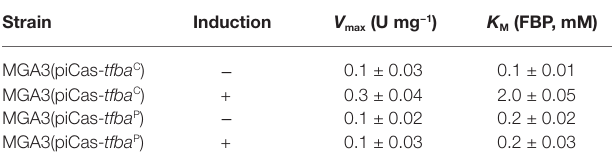
TABLE 3 | FBA (FBP cleavage) activities in crude extracts of Bacillus methanolicus MGA3(piCas- tfba C ) and MGA3(piCas- tfba P ) without ( − ) and with (+) induction of CRISPR interference (CRISPRi).